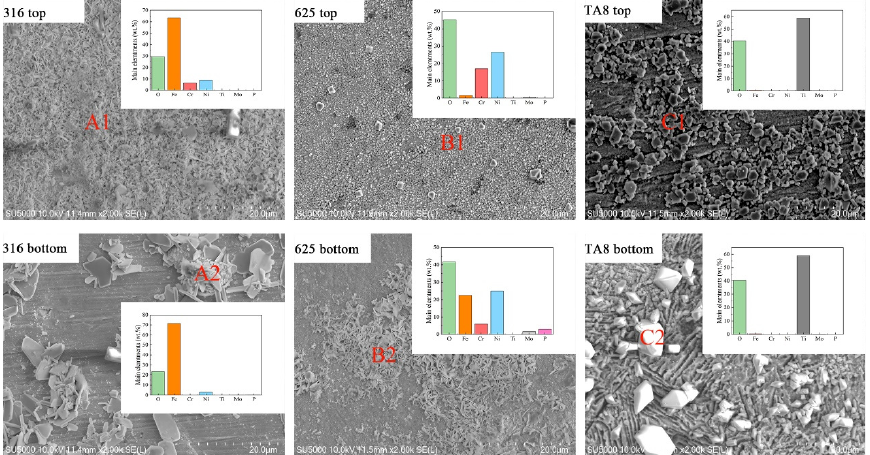
Figure 3. SEM images and main elements compositions of the oxide films formed on 316 SS, Alloy 625, and TA8 after exposure to SCW at experiment Run-6 for 200 h.